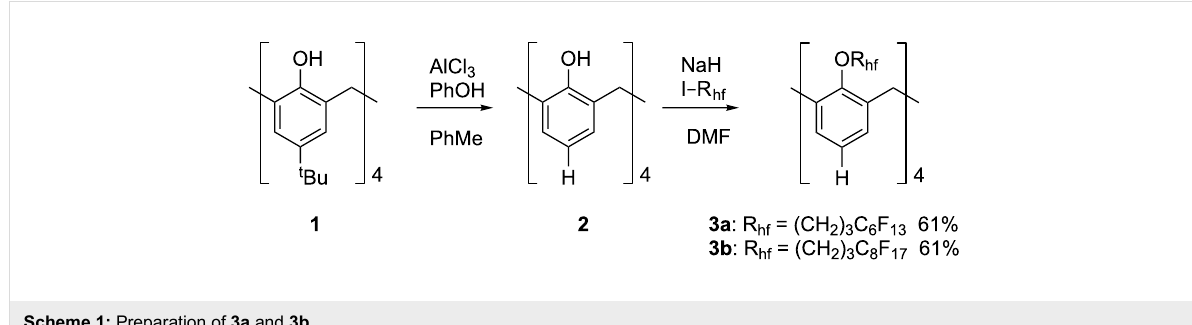
sensing applications because it has the largest available surface area for host-guest interactions [10]. With appropriate function- ality and conformation, the calixarene can be tailored to bind preferentially with specific target guest